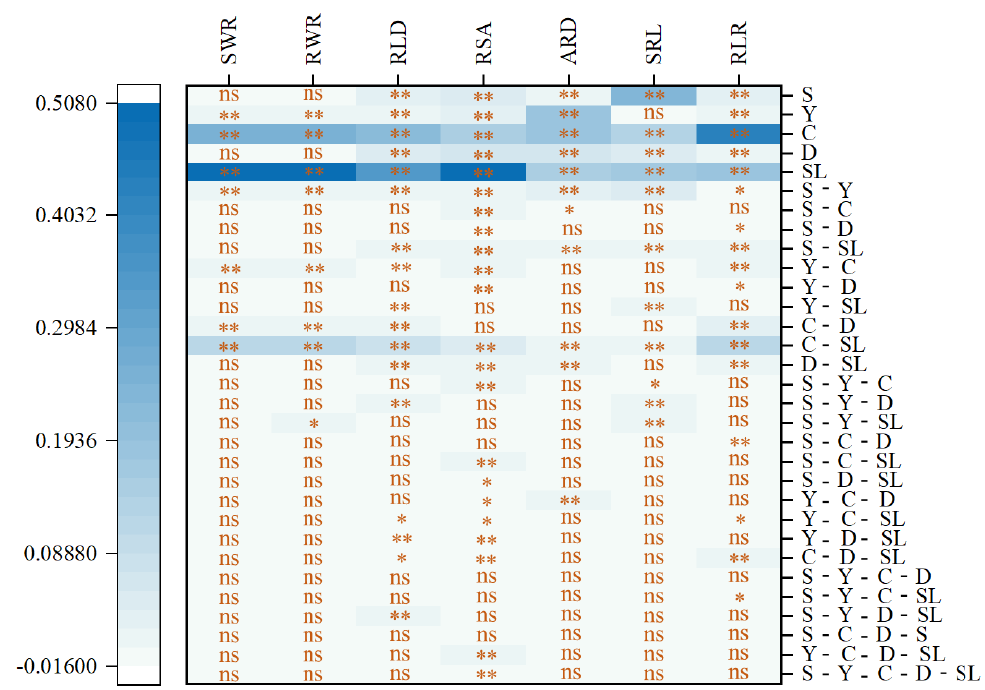
Figure 5. ANOVA results for shoot weight ratio (SWR, %), root weight ratio (RWR, %), root length density (RLD, mm cm −3 ), root surface area (RSA, m 2 ), average root diameter (ARD, mm), specific root length (SRL, m g −1 ) and root length ratio (RLR, m g −1 ). S: site; Y: year; C: cultivar; D: planting densities; SL: shading level. *, ** significant differences at p < 0.05 and p < 0.01, respectively. ns represents no significant differences.